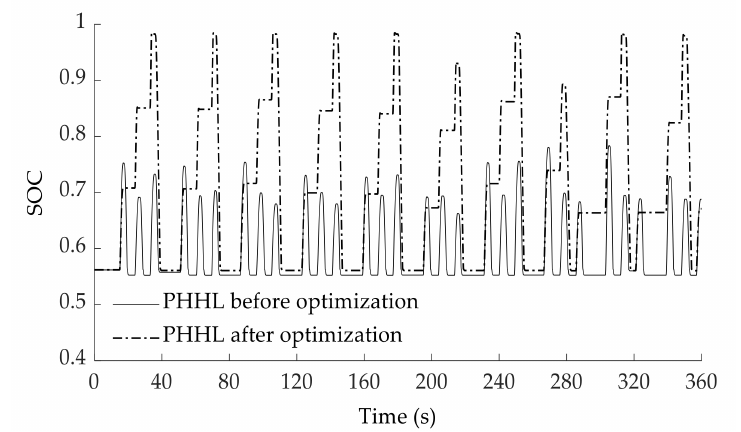
Figure 21. Accumulator SOC of the PHHL before and after optimization.